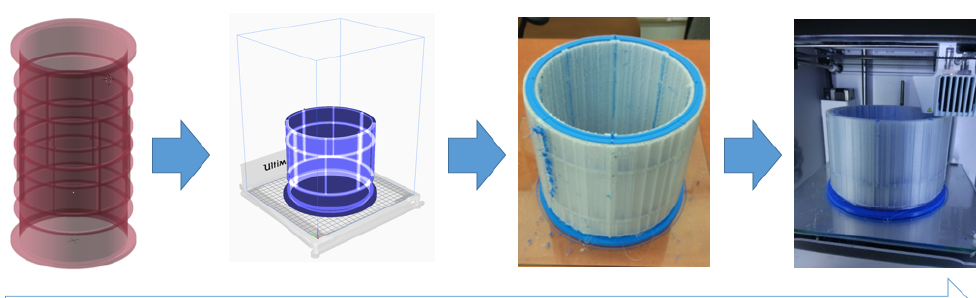
Figure 2. 3D printed ECT sensor building